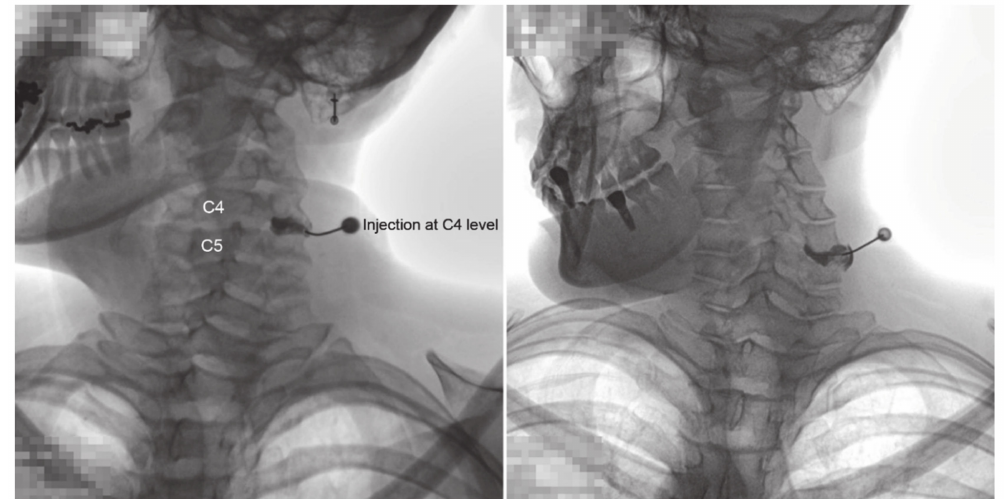
Figure 1. Arthrogram X-ray images showing the normal cervical facet joint flow.